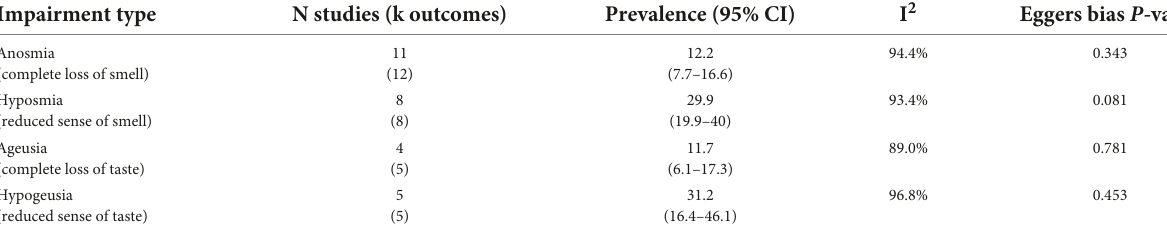
TABLE 2 Meta-analysis